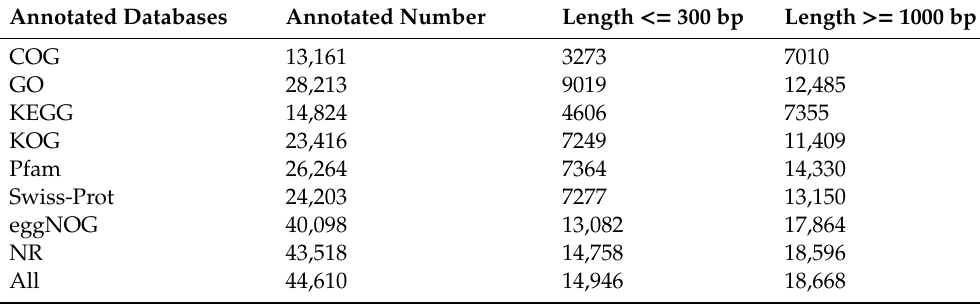
Table 2. Unigene function annotation statistics of Camellia oleifera ‘Huaxin’ transcriptome. COG: Clusters of Genes; GO: Gene Ontology; KEGG: Kyoto Encyclopedia of Genes and Genomes; Pfam: Protein family; KOG: EuKaryotic Orthologous Groups; NR: NCBI non-redundant protein